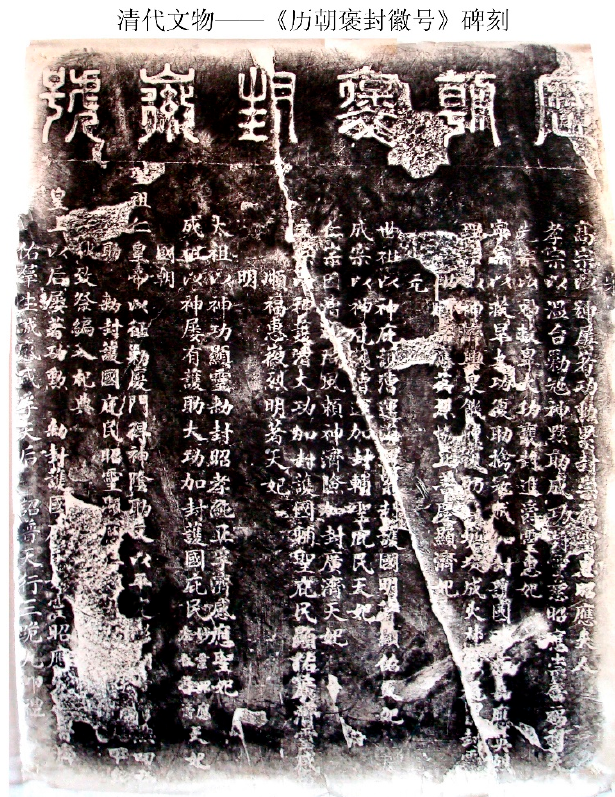
Figure 3. The Wooden Plate, “Performing Official Sacrifices in Spring and Autumn Ordered by Imperial Edict.” Preserved in The Ancestral Hall of the Celestial Empress at Xianliang Port. Source: Provided by the Temple management board of Xianliang gang zuci.